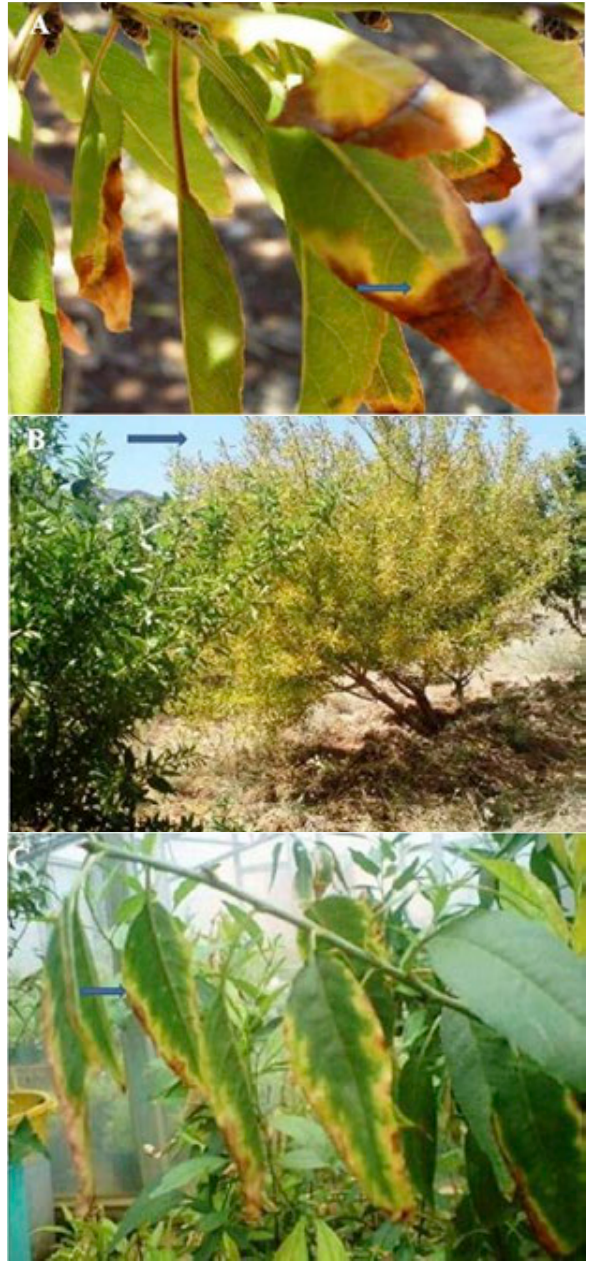
Figure 2. A. Typical leaf scorch symptoms on an almond tree, caused by X. fastidiosa. B. Almond tree with symp- toms of “golden death”. C. Almond leaf scorch symptoms on an almond seedling 5 months after